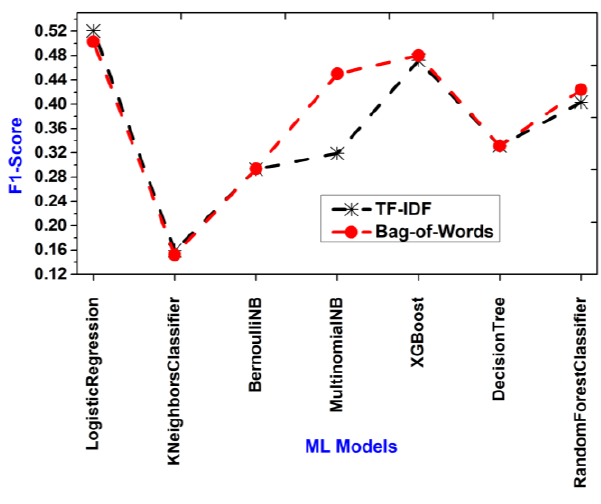
Fig. 2. F1-score for a dataset (google play store reviews) using seven ML algorithms with TF-IDF and bag of words